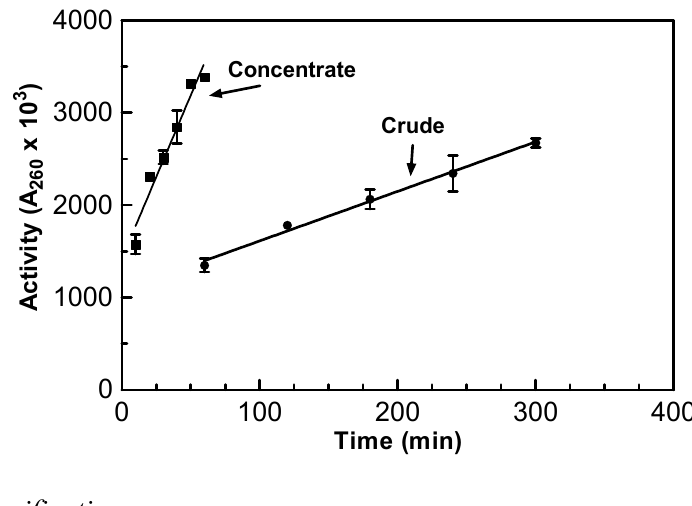
Figure 1. Comparison of the rates or slopes of the crude and concentrated samples in regards to enzyme activity. The assay used for these experiments was the acid soluble assay which was performed in triplicate at 55 °C.